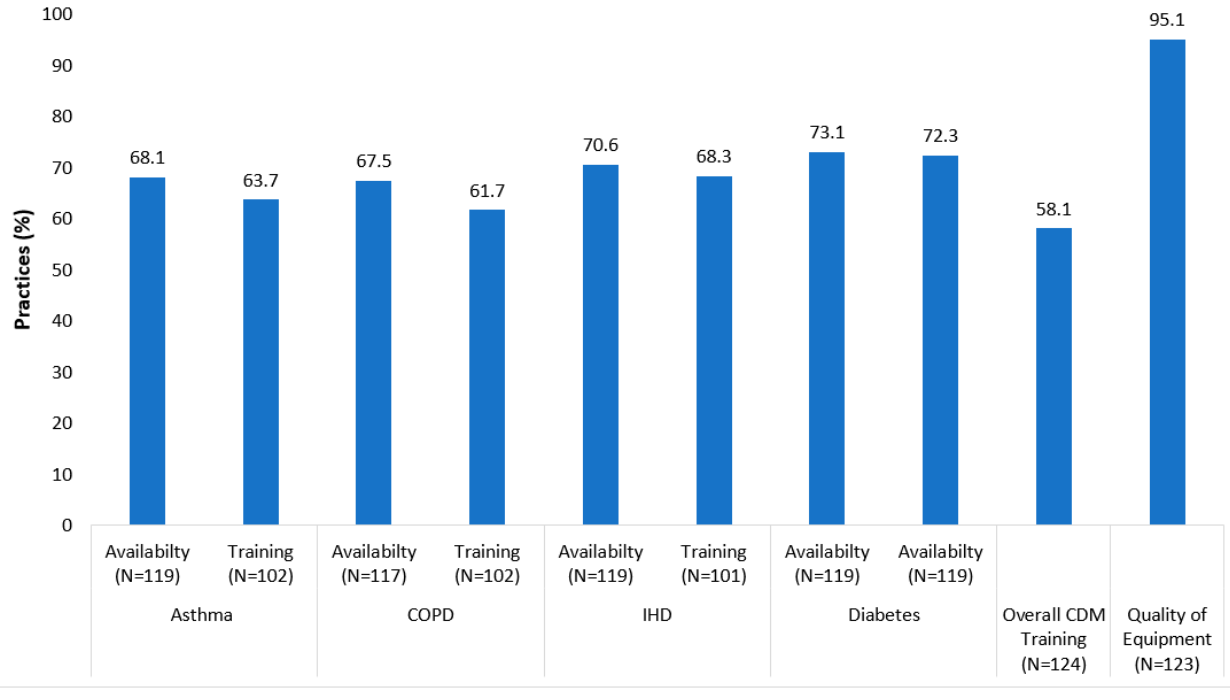
Figure 3. Staff availability and training adequacy to implement different chronic conditions under HSE CDM programme in general practice. COPD = Chronic Obstructive Pulmonary Disease, IHD = Ischemic Heart Disease.